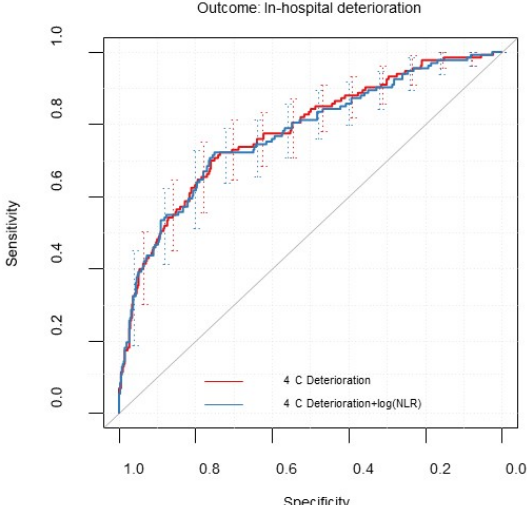
Figure 2. Receiver operating characteristic curve for modified 4C Deterioration Model and updated